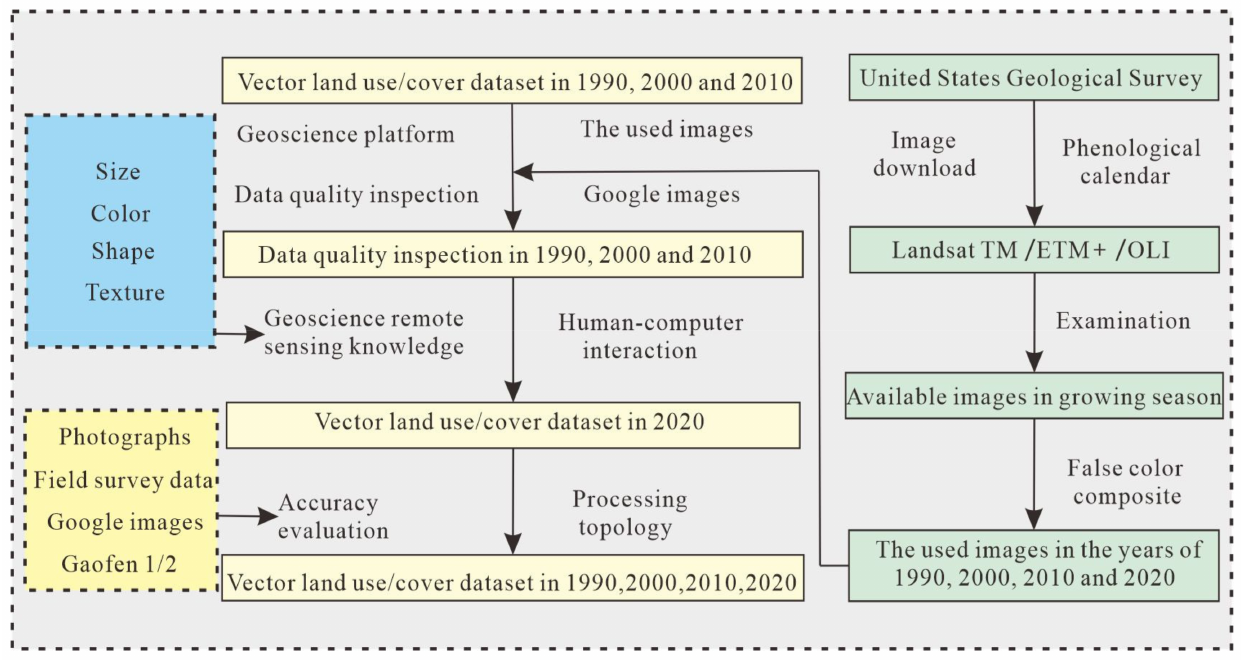
Figure 2. Schematic diagram of land use/cover data inspection in 1990, 2000 and 2010 and production in